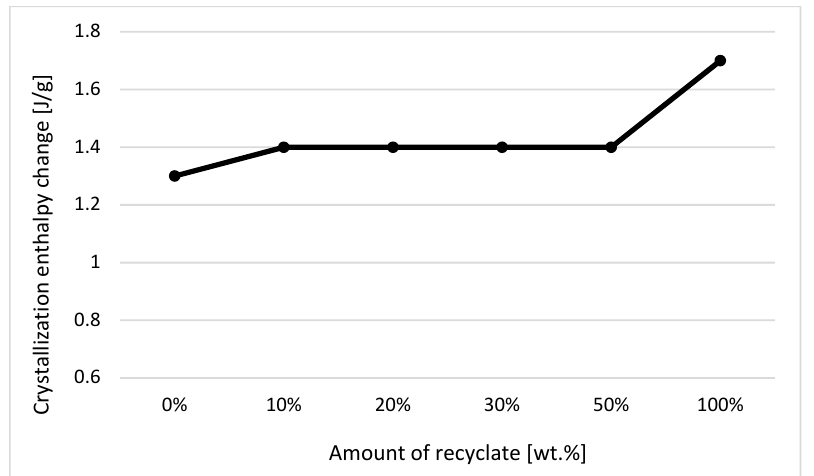
Figure 2. Dependence of the change in enthalpy of crystallization on the proportion of weight of the recycled material before exposure of samples to elevated temperature—component 1.